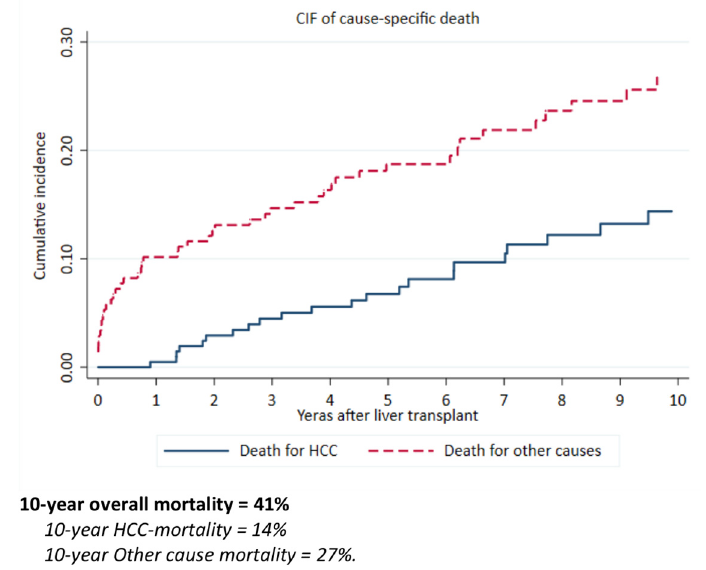
Figure 2. Cumulative Incidence Function (CIF) of cause-specific death.